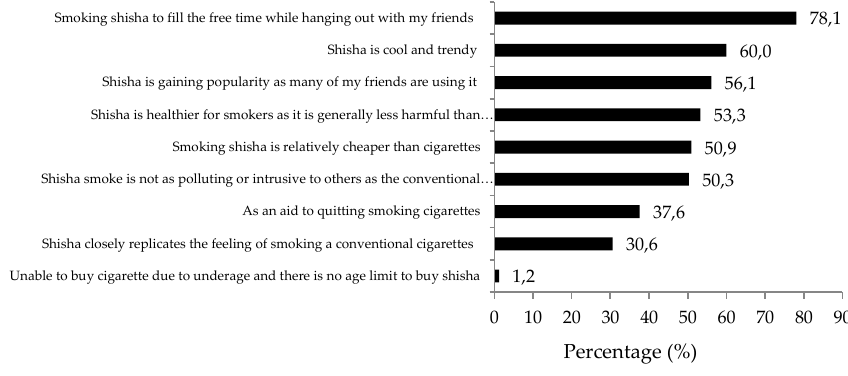
Figure 1. Reasons for smoking shisha ( N = 503).